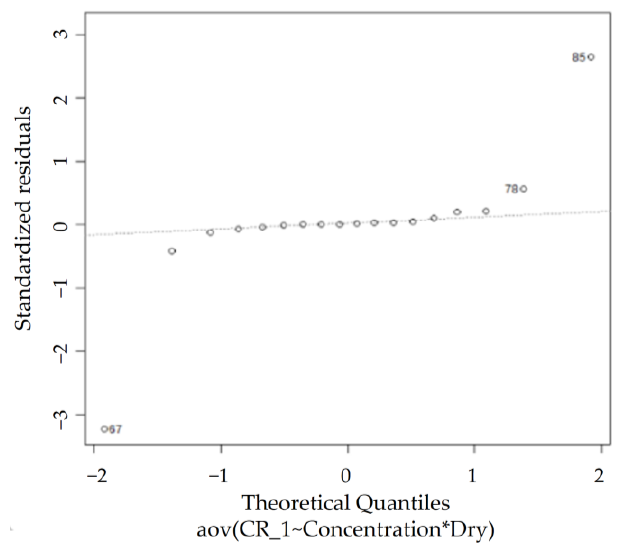
Figure 17. ARI normal QQ plot. Table 6. Shapiro and Levene’s test result